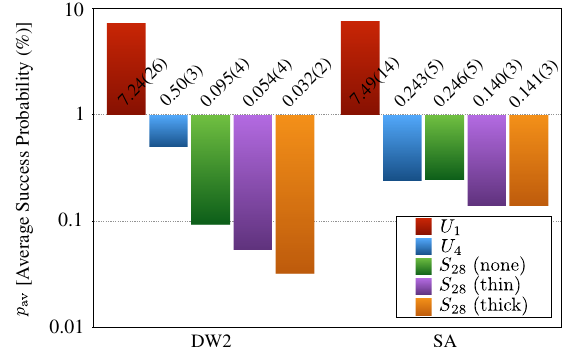
FIG. 3. Average success probabilities p (after a gauge av average) for DW2 and SA using different types of disorder. In all Sidon instance classes ( S 28 ) the classical codes outperform DW2. Furthermore, success probabilities for bimodal disorder ( U 1 ) are much larger than for any other instance class, therefore suggesting that the degeneracy produced by bimodal disorder makes this instance class too easy to detect quantum speedup. Note also that the classical codes, on average, do not seem to distinguish between instances with thick and thin barriers. Labels are from left to right.